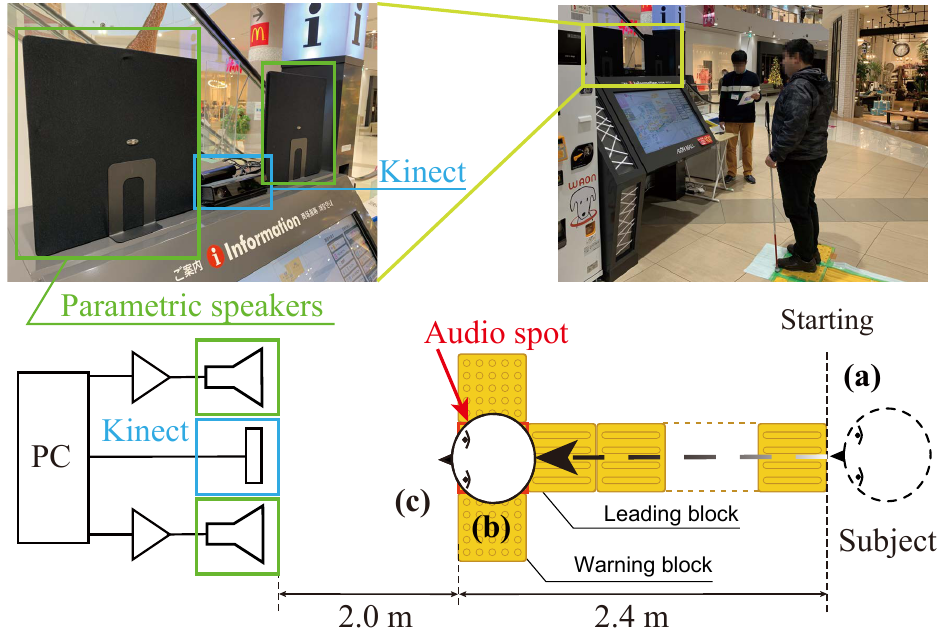
Figure 7. Experiment overview: ( a ) Subject walks from the beginning of the braille block. ( b ) When the subject reaches the warning block, a stereophonic sound is generated by a parametric speaker. ( c ) After hearing the sound, the subject moves in the direction of the target facility indicated by the earcon.